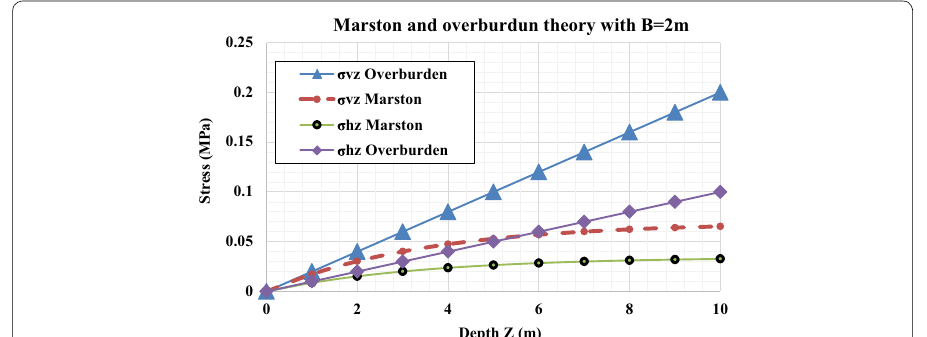
Fig. 2 Estimates of stress (σ vz and σ hz ) based on the overburden and Marston theories; φ ′ (MN/m 3 ) and K